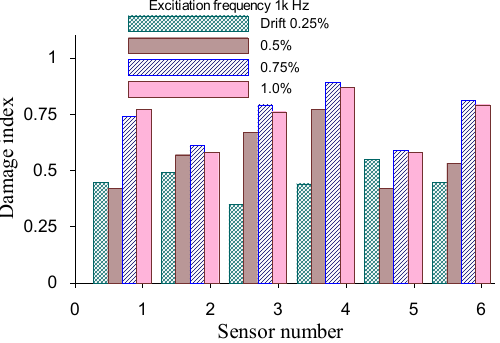
Figure 13. Damage index at each drift ratio for RCW 1 (excitation frequency 1 kHz).